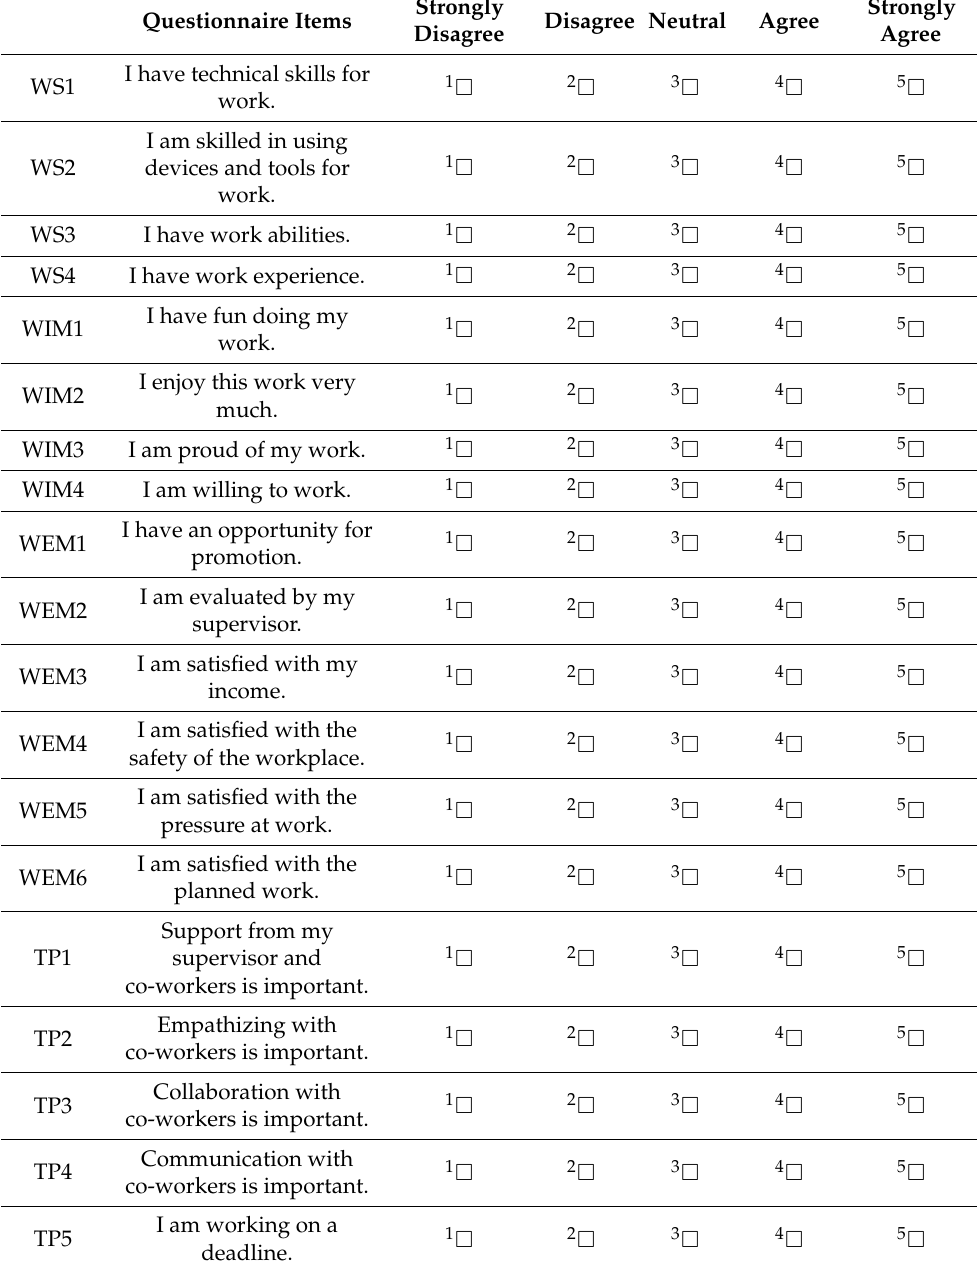
Table A1. Survey on psychological factors regarding motivation and awareness of